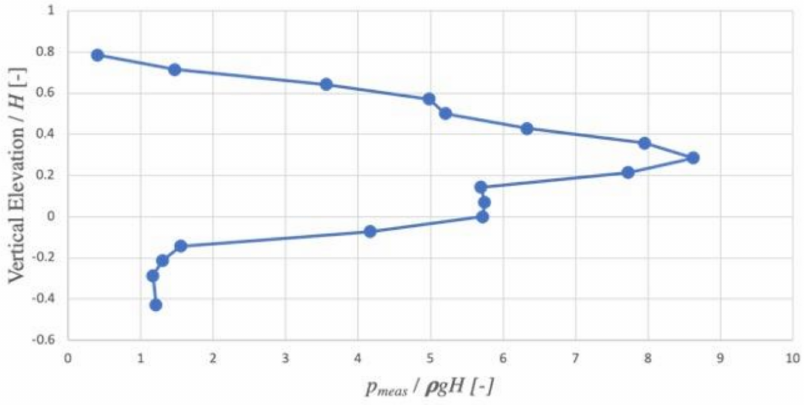
Figure 11. The landward pressure measurement at various vertical positions for the no duct case at breaking position.